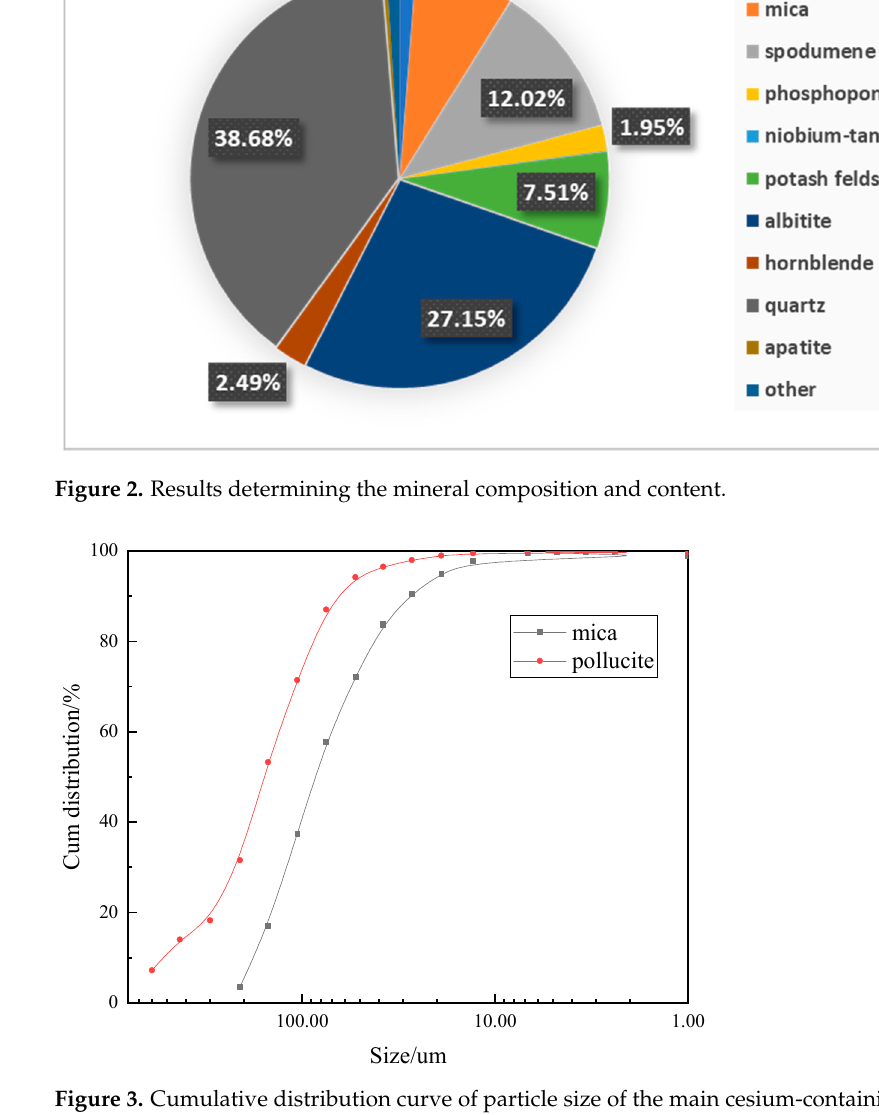
Figure 2. Results determining the mineral composition and content.